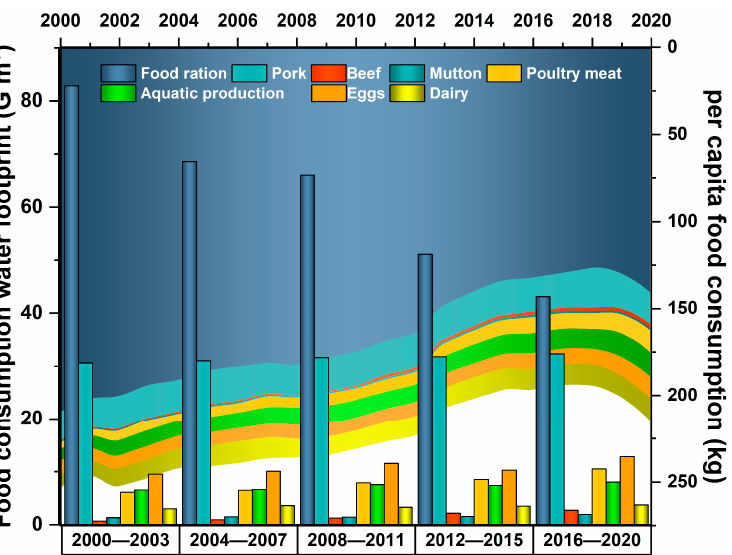
Figure 5. Dynamics of the water footprint of the consumption of different foods over time. Note: The bar chart represents the average value of the water footprint of grain consumption in Northwest China over time. The area map represents the amount of grain consumed per capita in Northwest China.